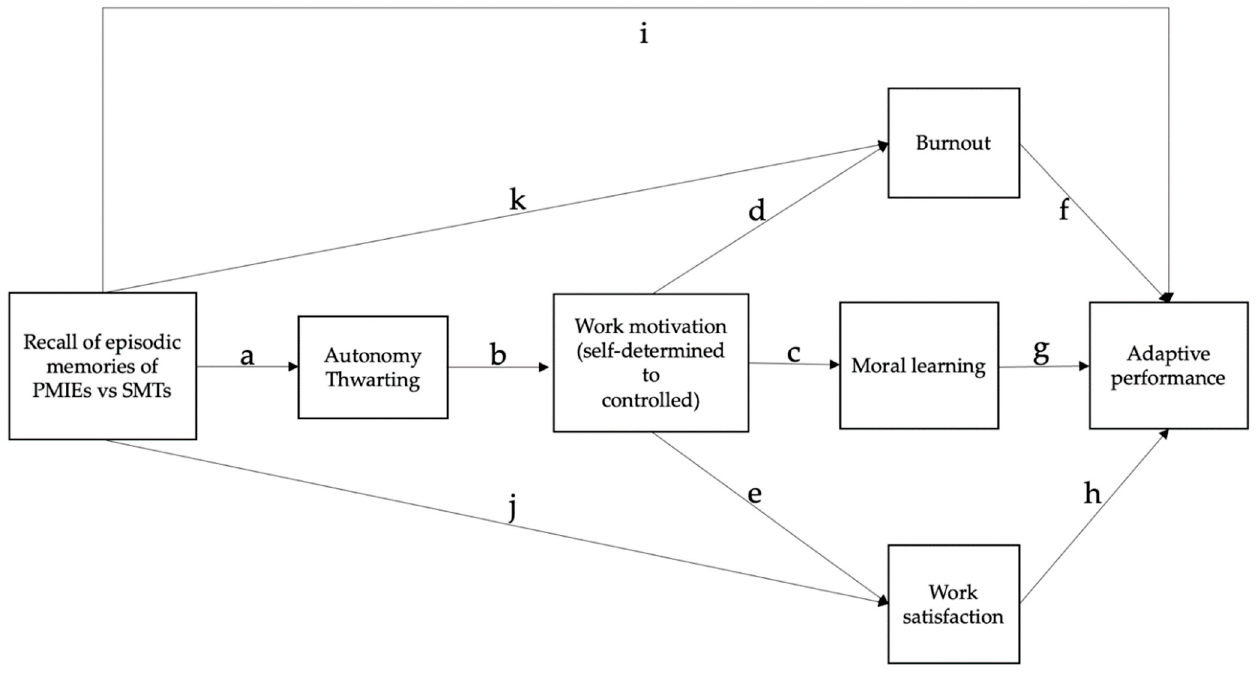
Figure 1. Conceptual Model of the Direct and Indirect Effects of PMIE recall on Burnout, Work Satisfaction and Adaptive Performance.